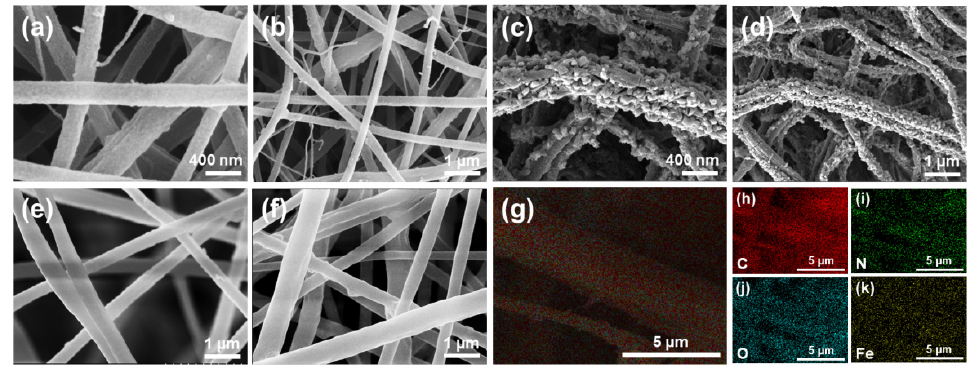
Figure 2. SEM images of the iMIL-88A/PAN/PVP ( a , b ) and pMIL-88A/PAN ( c , d ) NFMs with scale bars of 400 nm and 1 μ m. SEM images of the iMIL-88A/PAN ( e ) and bMIL-88A/PAN ( f ) NFMs. Overall ( g ), C ( h ), N ( i ), O ( j ), and Fe ( k ) elemental mappings of a pMIL-88A/PAN NFM.